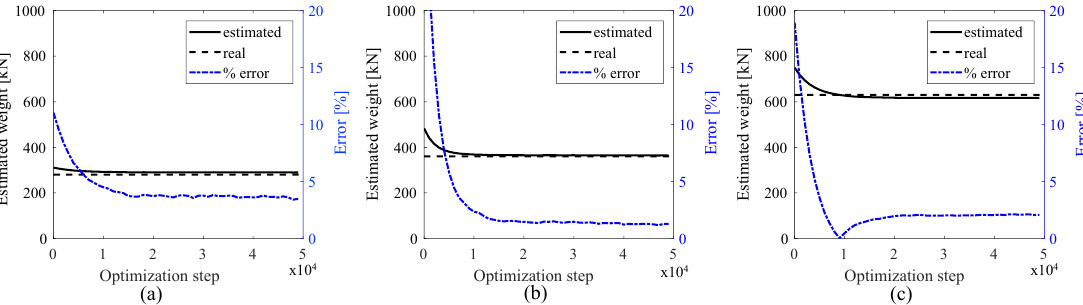
Figure 7. Weight estimations for the first simulation case; ( a ) type 1 truck; ( b ) type 2 truck; and ( c ) type 3